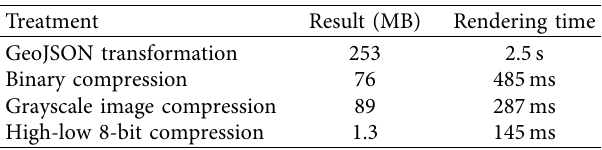
Table 2: Comparison of the various treatment results and the rendering